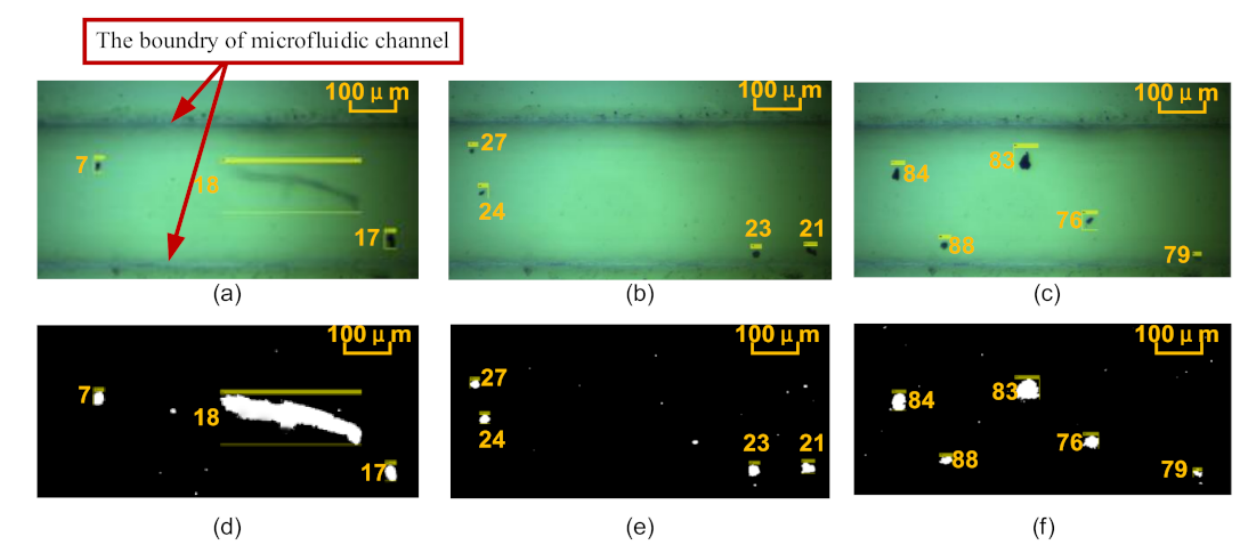
Figure 4. Example of automatic tracking results for wear particles: ( a ) original image of particles #7, #17, and #18; ( b ) original image of particles #21, #23, #24, and #27; ( c ) original image of particles #76, #79, #83, #84, and #88; ( d ) binary image of particles #7, #17, and #18; ( e ) binary image of particles #21, #23, #24, and #27; ( f ) binary image of particles #76, #79, #83, #84, and #88.